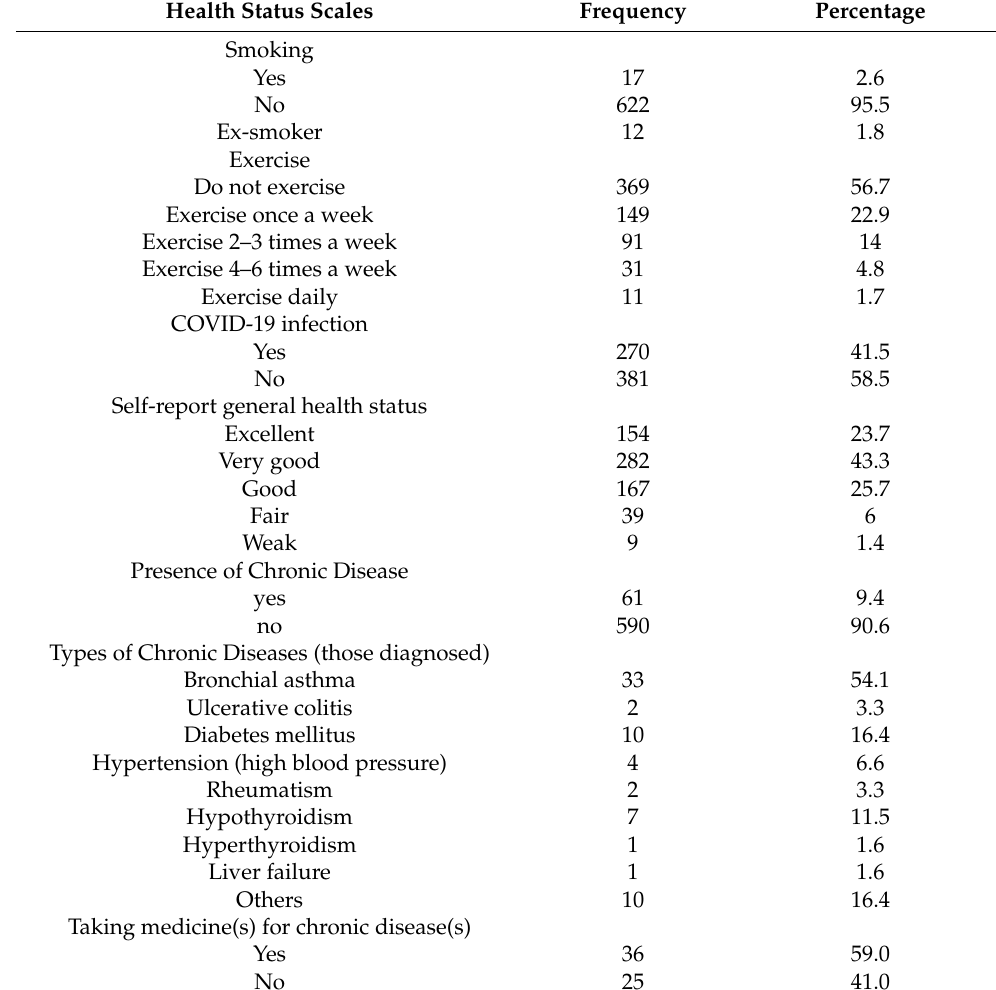
Table 2. Frequency and percentage distribution of health indicators among the respondents.